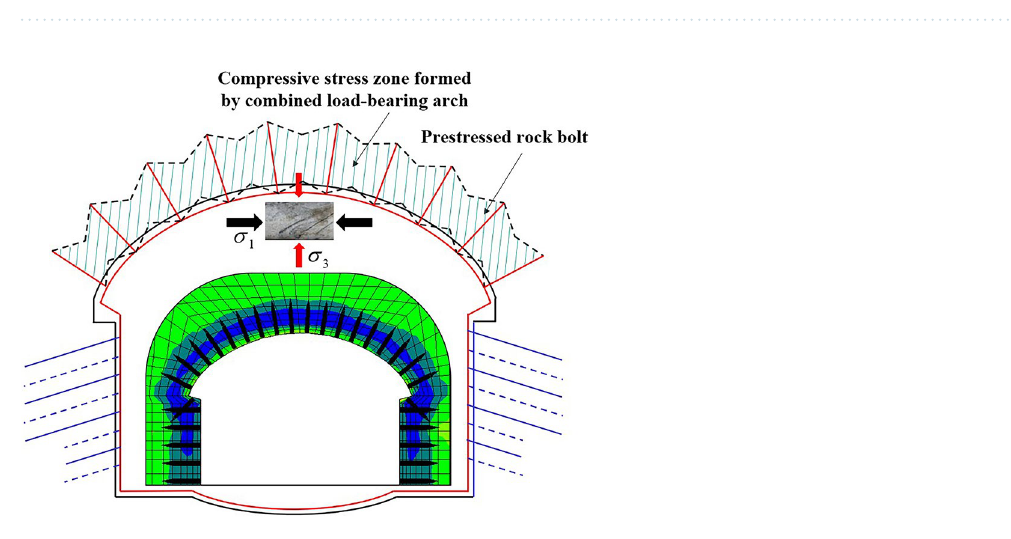
Figure 5. Stress state of surrounding rock after excavation.